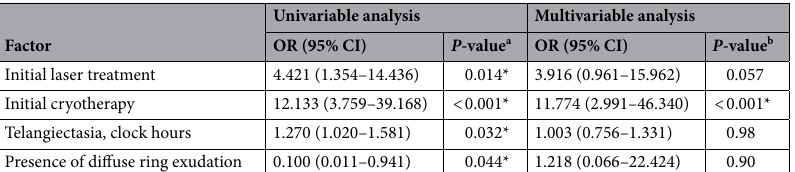
Table 4. Factors associated with a need for secondary interventions in patients with Coats’ disease. CI confidence interval, OR odds ratio. * P -values of < 0.05 are considered statistically significant. a Univariable logistic regression analysis. b Multivariable logistic regression